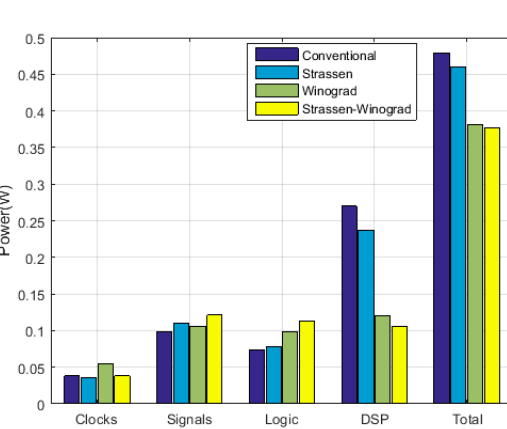
Figure 11. Power consumption of designs based on different algorithms.